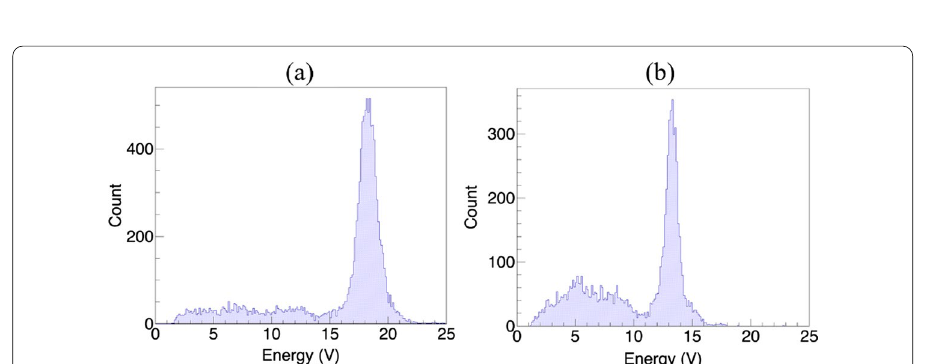
Fig. 7 The energy spectra of ( a ), a middle crystal and b an edge crystal in the 3